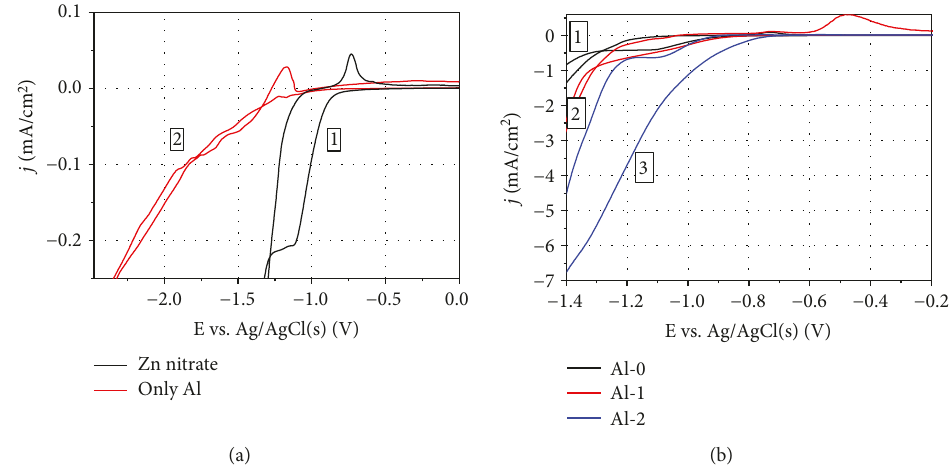
Figure 1: Cyclic voltammograms of ITO electrode in zinc nitrate electrolytes with di ff erent concentrations of aluminum nitrate: (a) 1 — Al-free zinc nitrate electrolyte and 2 — Zn-free aluminum nitrate electrolyte. (b) 1 — Al-free electrolyte, 2 — 1 at.% of aluminum, and 3 — 2 at.% of aluminum. Scan rate — 20mV/s. Table 1: Zinc deposition electrolytes and applied deposition